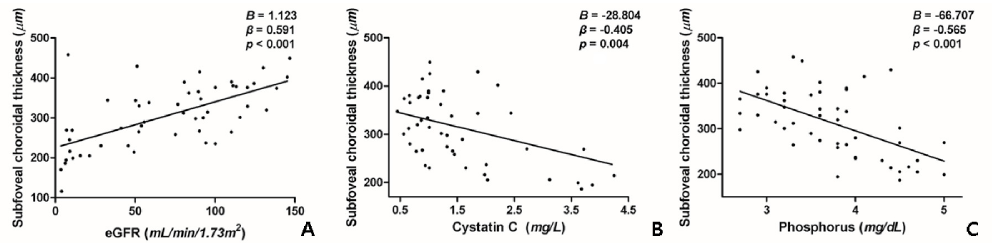
Figure 2. Univariate association between subfoveal choroidal thickness and cystatin C and phosphorus levels and the estimated glomerular filtration rate in patients with proliferative diabetic retinopathy. ( A ). Estimated glomerular filtration rate (eGFR) is positively correlated with subfoveal choroidal thickness (SFChT). ( B, C ). Serum cystatin C ( B ) and phosphorus ( C ) levels are negatively correlated with SFChT.